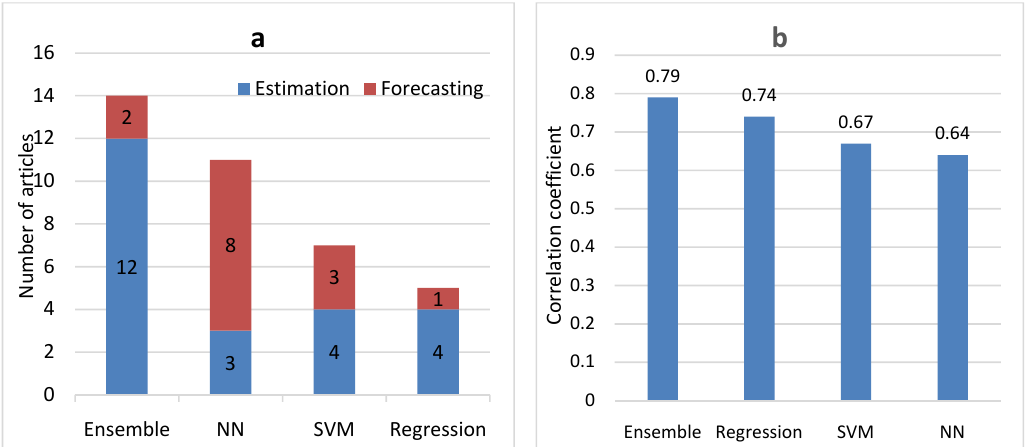
performance of major algorithms (Ensemble learning, regression, SVM and